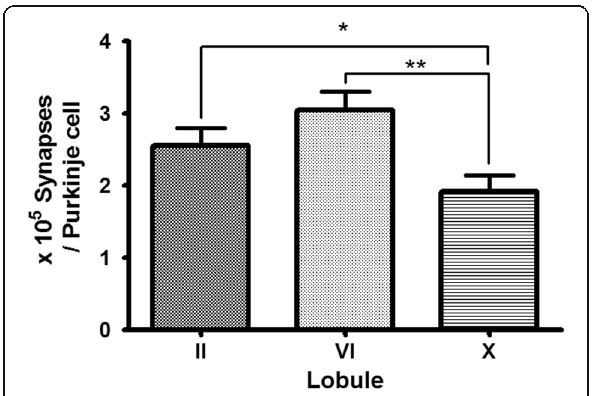
Fig. 5 The number of synapses per Purkinje cell. (*: p < 0.06, **: p < 0.006)